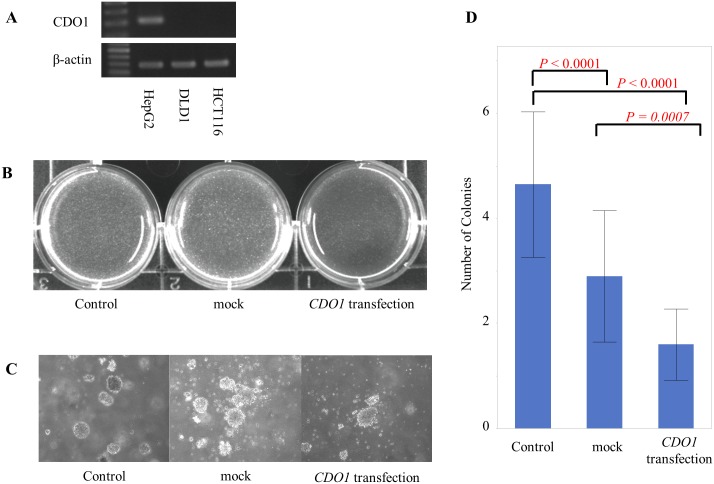
Results of the anchorage-independent colony formation assay.A: Expression of CDO1 cDNA by RT-PCR. The positive control was HepG2 cells, and the negative control was DLD1 cells [8, 16, 18]. In HCT116 cells, expression of CDO1 was not observed. B: Control, not transfected; mock, mock treatment; CDO1 transfection, CDO1 cells transfected with pcDNA 3.1-CDO1. The colonies were photographed under UV after staining with ethidium bromide staining. The number of colonies was small in the cells transfected with CDO1. C: Colony formation of each experimental condition. Colonies were photographed under phase-contrast microscope. The image is magnified 100 times. D: The numbers of colonies are shown. Cell proliferation by HCT116 cells was suppressed by transfection of CDO1.